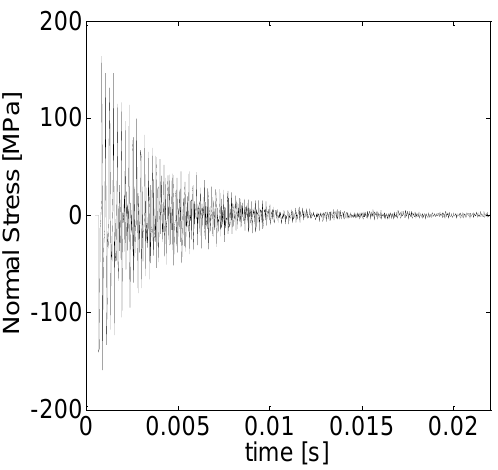
Figure 10. Time history of the computed axial stress. Spectral amplitudes and frequencies for the axial stress waves are summarized in Table 8. The optimal values of the elastic and damping properties were found to be 10 kNmm − 1 and 0.25 Nmm − 1 s, respectively, for the inclined stiffnesses and dashpots and 20 kNmm − 1 and 0.25 Nmm − 1 s for the axial ones, respectively. The optimized values for the inclination angle and acting diameter were 8 ◦ and 16 mm, respectively. Figure 12 provides a comparison between the measured and computed spectra for the torsional stress